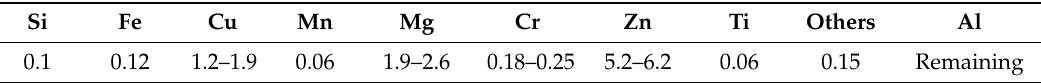
Table 1. Chemical composition of the 7475-T7351 aluminum alloy (%